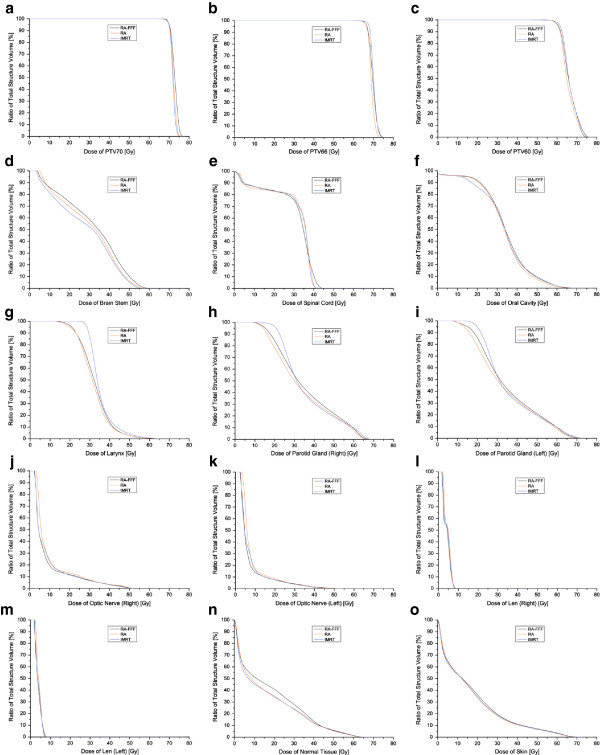
The dose distributions for three techniques.